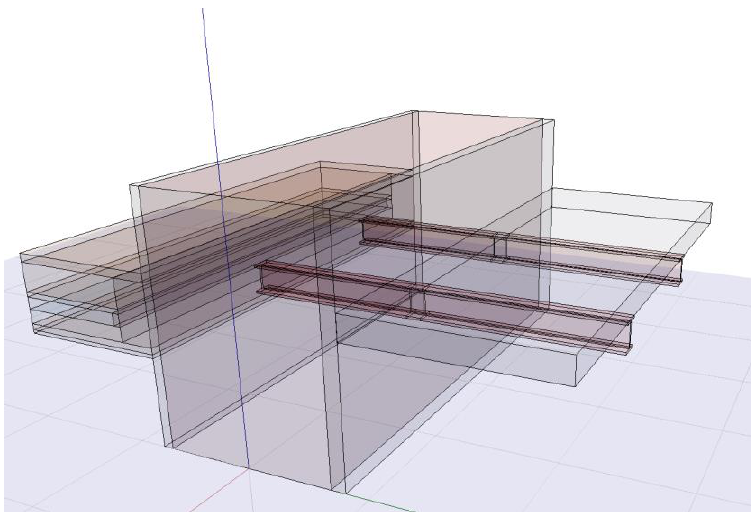
Figure 12. General geometric model—alternative I.